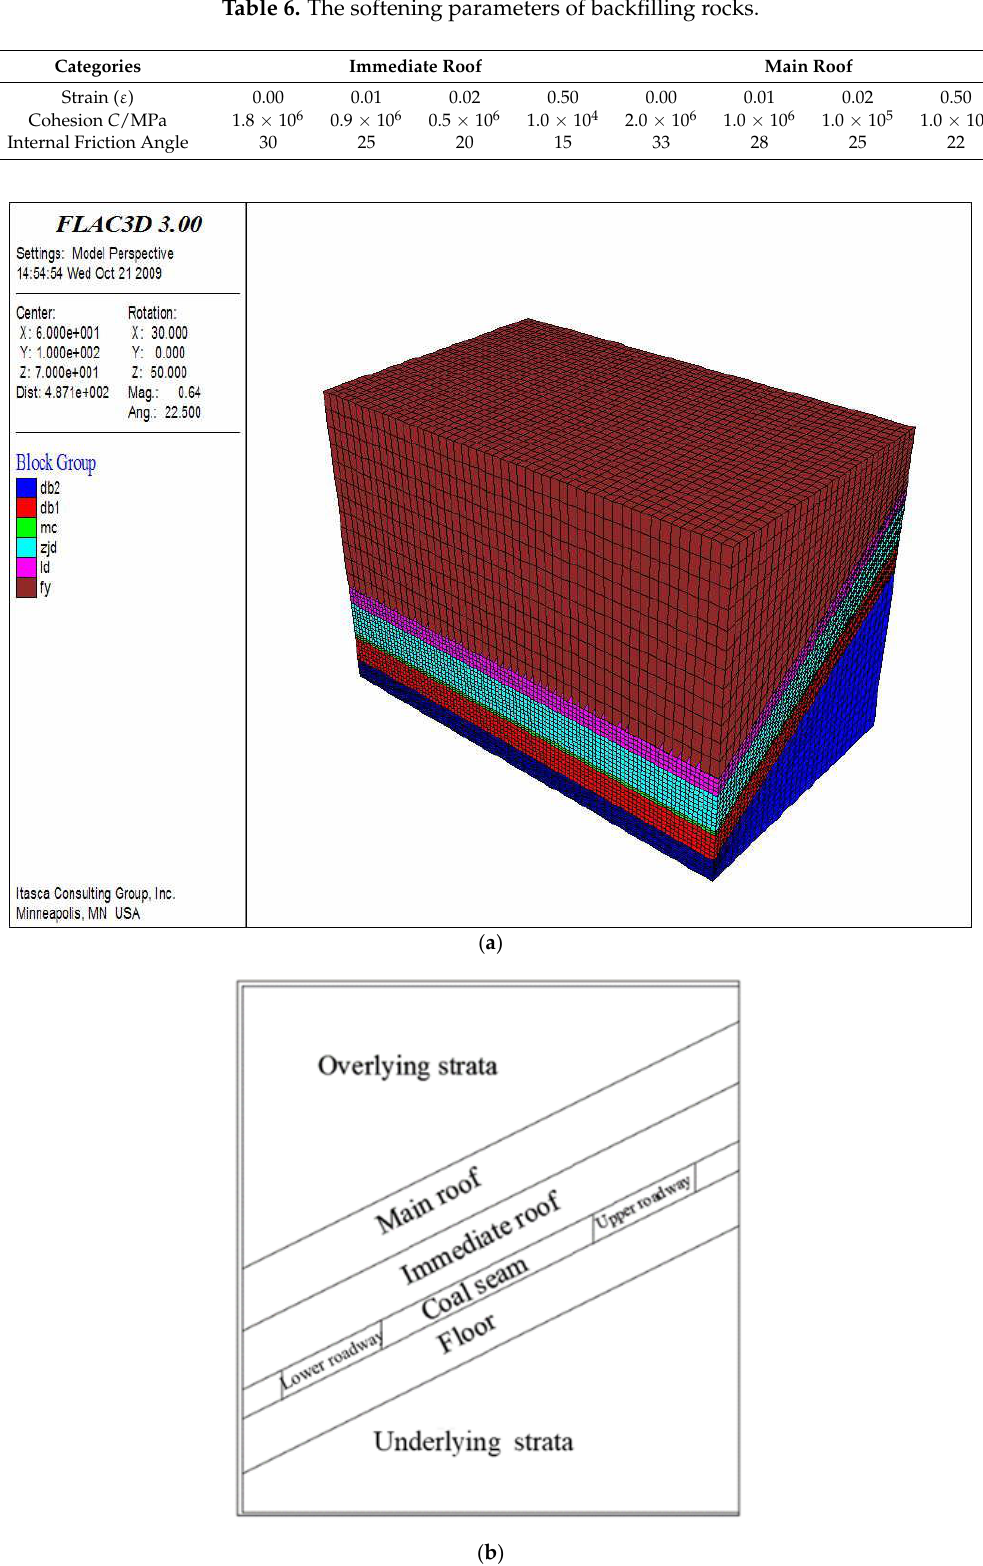
Figure 10. Schematic diagram of the model: ( a ) model mesh and ( b ) overall model structure.